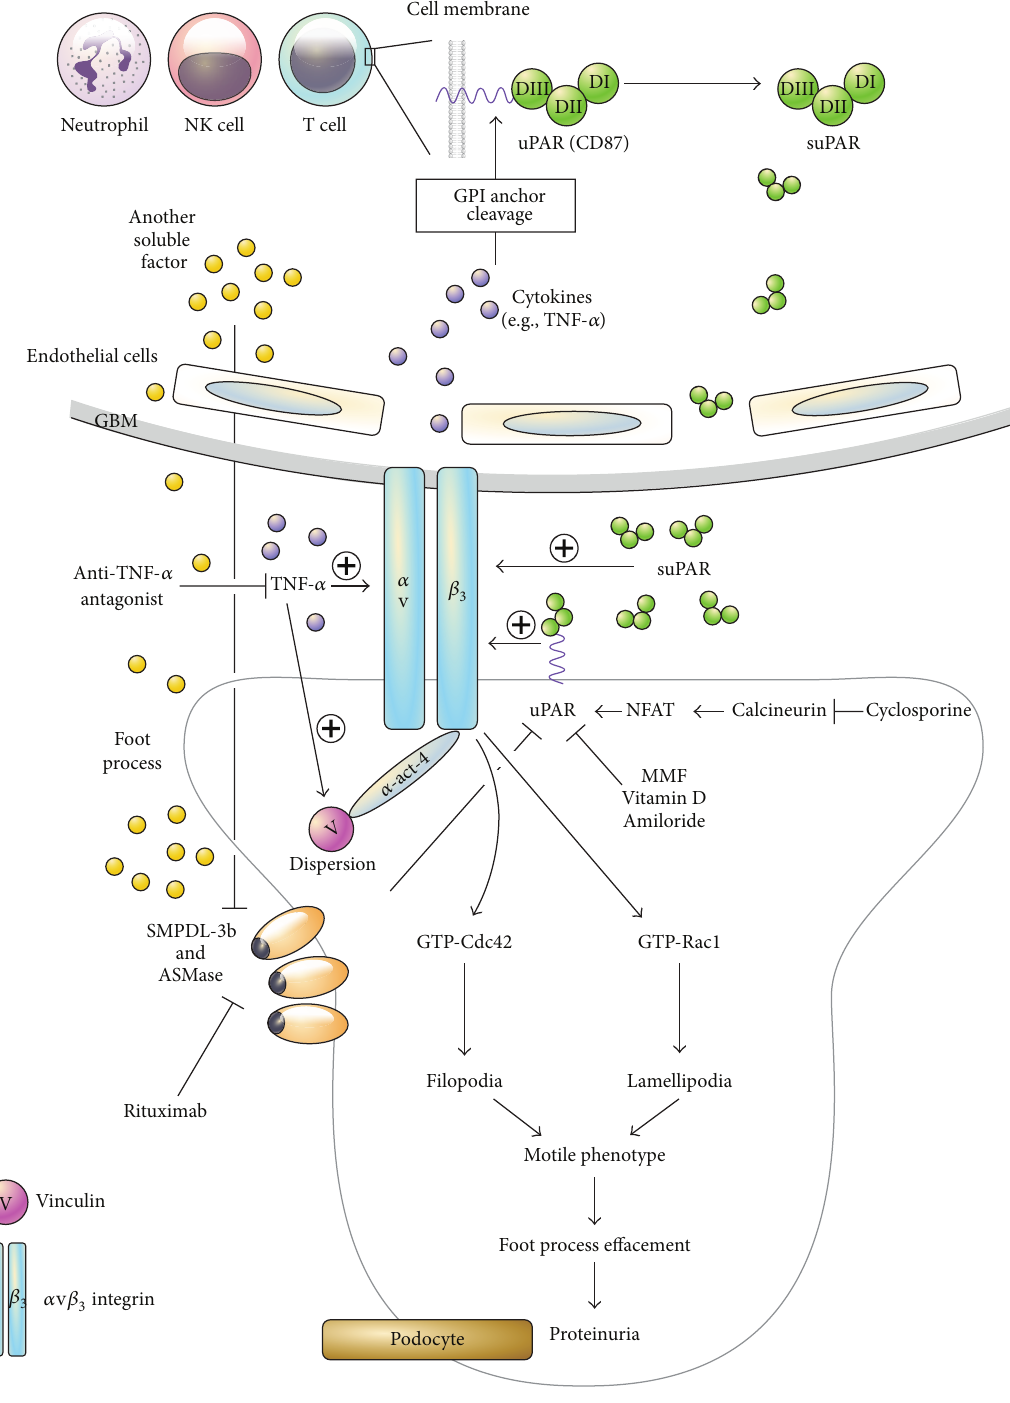
Figure 1: A hypothesis for the pathogenesis of suPAR-mediated FSGS. suPAR is formed from various immune cells after cleavage of GPI anchor by cytokines such as TNF- 𝛼 . suPAR can activate 𝛼 v 𝛽 3 integrin of podocytes. TNF- 𝛼 can directly activate podocyte 𝛼 v 𝛽 3 integrin and vinculin. Another serum factors might decrease SMPDL3b in podocytes, causing 𝛼 v 𝛽 3 integrin activation through increased binding of suPAR/uPAR and 𝛼 v 𝛽 3 integrin. Cdc42 and Rac1 can be activated by uPAR- 𝛼 v 𝛽 3 integrin signaling and the podocyte actin cytoskeleton shifts from a stationary to a motile phenotype, thereby causing foot process effacement and proteinuria. uPAR- 𝛼 v 𝛽 3 integrin signaling in podocytes can be blocked through various pathways. NK, natural killer; uPAR, urokinase-type plasminogen activator receptor; suPAR, soluble urokinase-type plasminogen activator receptor; GPI, glycosylphosphatidylinositol; TNF, tumor necrosis factor; NFAT, nuclear factor of activated T cells; MMF, mycophenolate mofetil; GTP, guanosine-5 󸀠 -triphosphate; SMPDL, sphingomyelin phosphodiesterase acid-like; ASMase, acid